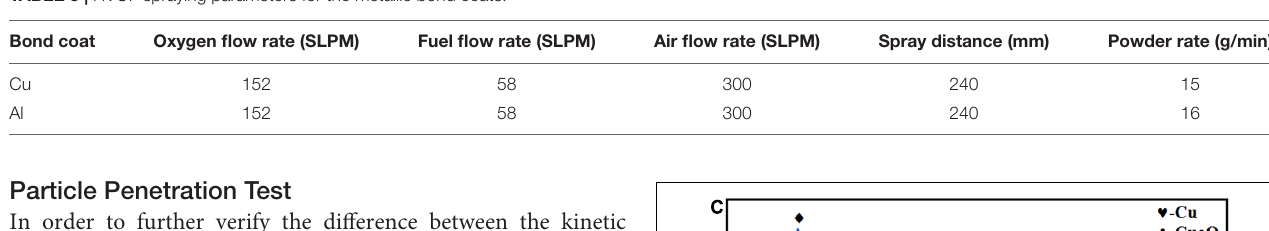
TABLE 3 | HVOF spraying parameters for the metallic bond coats.